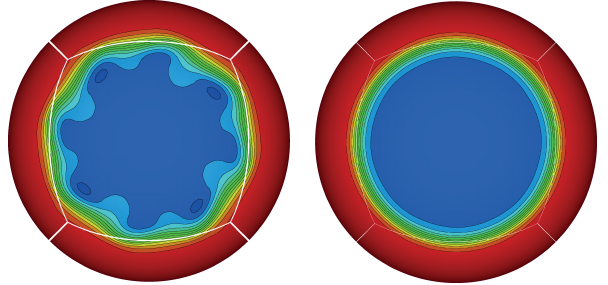
Figure 15. Numerical results of water depth for balanced setup of barotropic instability test on two grids G 24 (left) and G 72 (right). Contour lines vary from 9000 to 10100m.